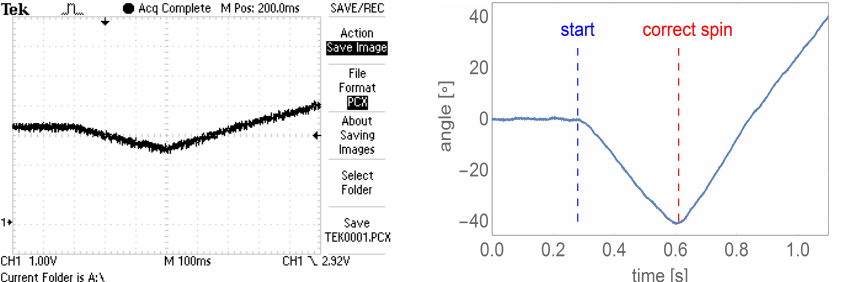
Figure 9. The oscillogram of the analog encoder signal recorded during the start-up of the controlled motor based on the voltages from the additional motor windings ( left figure), the graph of the rotation angle versus time corresponding to the oscillogram, with the moment of rotor movement marked (start) and determination of the correct spin direction (correct spin) ( right